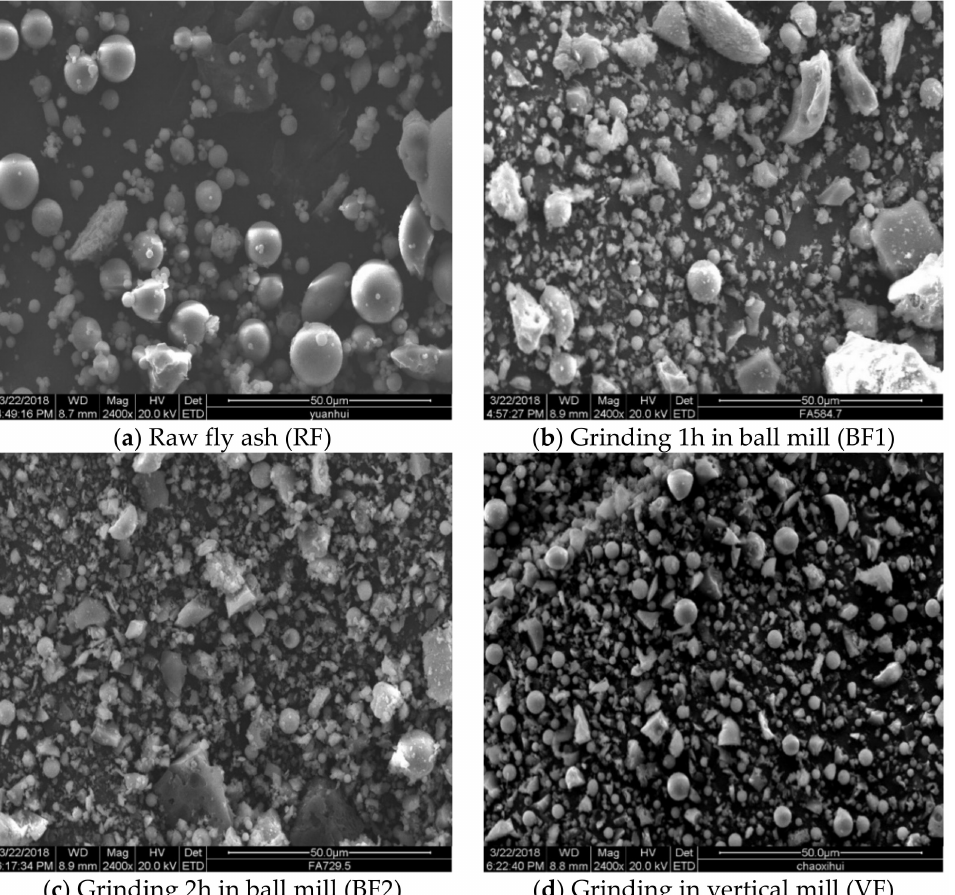
Figure 2. SEM images of different fly ash. ( a ) Raw fly ash (RF). ( b ) Grinding 1h in ball mill (BF1). ( c ) Grinding 2h in ball mill (BF2). ( d ) Grinding in vertical mill